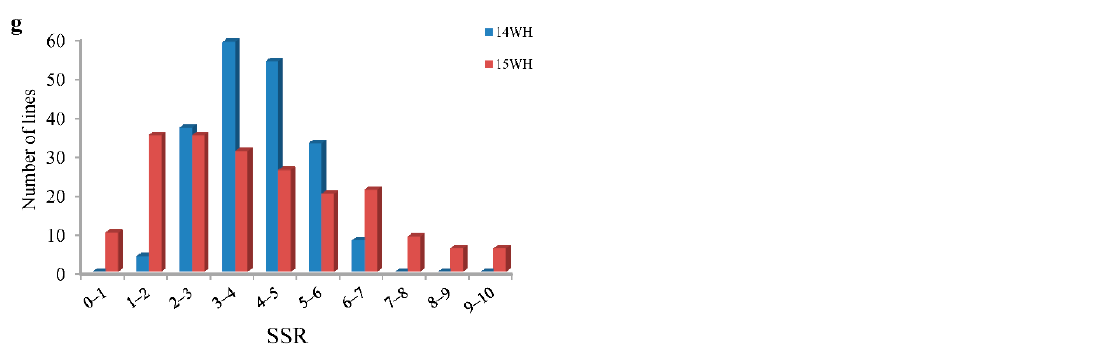
Figure 3. Phenotypic distributions of ADL, Cel, Hem, SG, BF, F and SSR in the YW-DH population derived from the cross ‘Y689 ′ × ‘Westar’. ( a ) Acid detergent lignin content, ( b ) cellulose content, ( c ) hemicellulose content, ( d ) syringyl/guaiacyl monolignol ratio, ( e ) breaking force, ( f ) breaking strength and ( g ) resistance against Sclerotinia sclerotiorum . 14WH, 14ND, 15WH and 15ER repre- sent four environments with different colors. 14WH: Wuhan, 2014–2015; 14ND: Weinan, 2014– 2015; 15WH, Wuhan, 2015–2016; 15ER, Ezhou, 2015–2016.